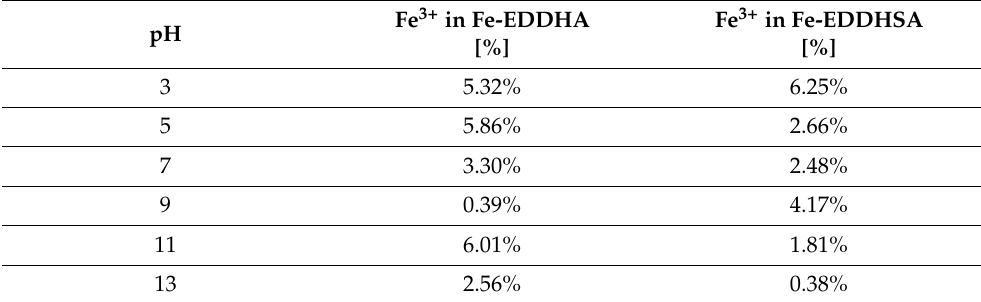
Table 1. The content of unbound iron(III) ions at time t = 0 in the aqueous medium at different pH values in the preparation of Fe-EDDHA and Fe-EDDHSA. Fe 3+ in pH